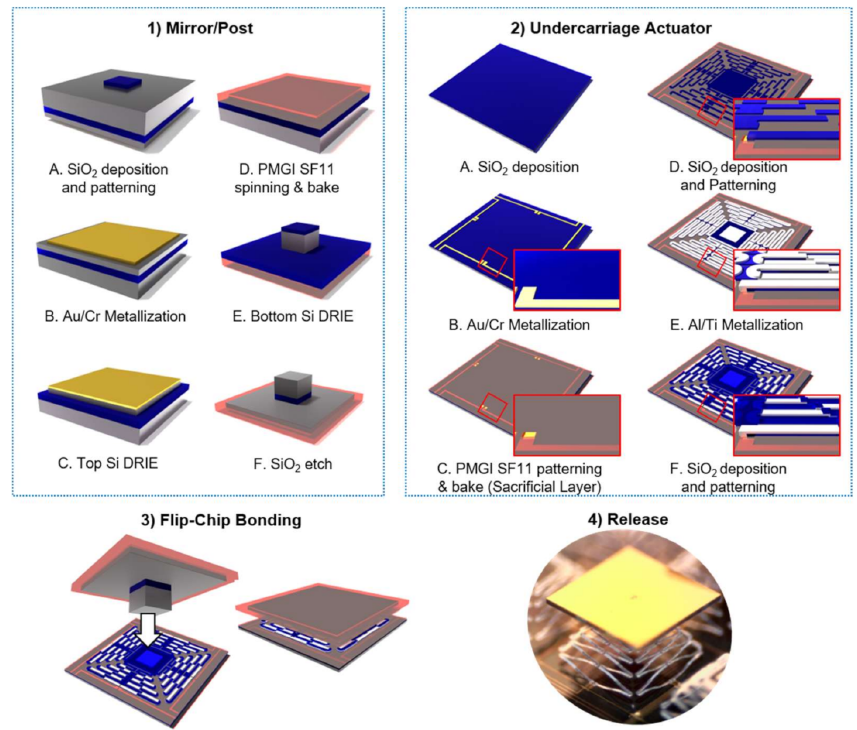
Figure 2. The fabrication process flow of the large angle micromirror device is composed of four steps: (1) Mirror/post-fabrication on a SOI wafer, (2) Undercarriage actuators fabrication using photoresist as the sacrificial layer, (3) Flip-chip bonding between the actuators and the mirror/post chip, (4) Release of the structure using solvent and a supercritical dryer (optical